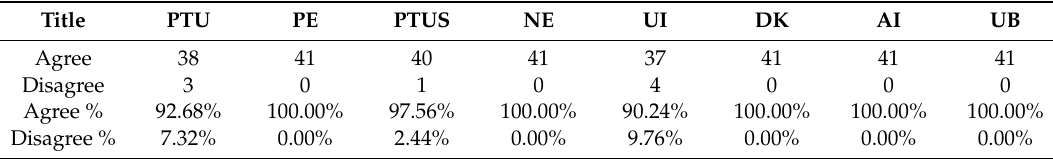
Table 2. Results of construct evaluation using the modified Delphi